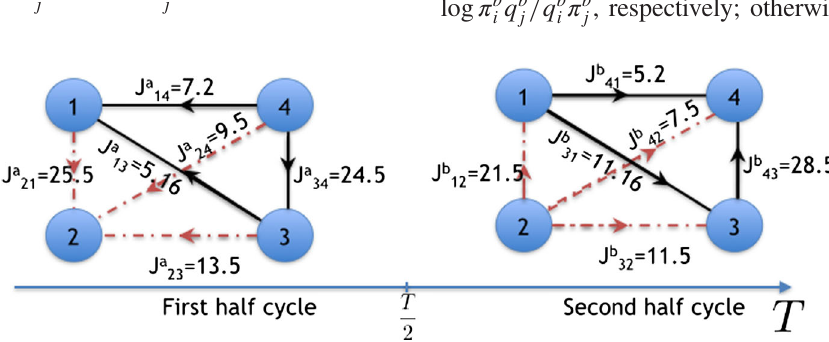
FIG. 3. The currents of the stochastic pump constructed to mimic the NESS in Fig.(2). The pumped currents during the first (left) and second (right) half-periods are shown. On each of the edges, the current directions in the two half periods are opposite. Note that there are no current loops in both of the half